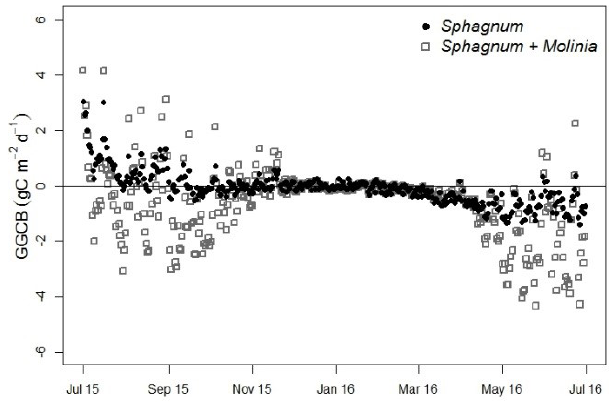
Figure 4. Greenhouse gas carbon budget (GGCB) average per day in Sphagnum and Sphagnum + Molinia